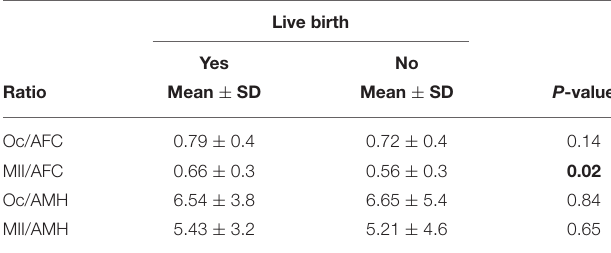
TABLE 3 | Oocyte yield indices in infertile women with or without live birth after the cumulative embryo transfer. Live birth Yes